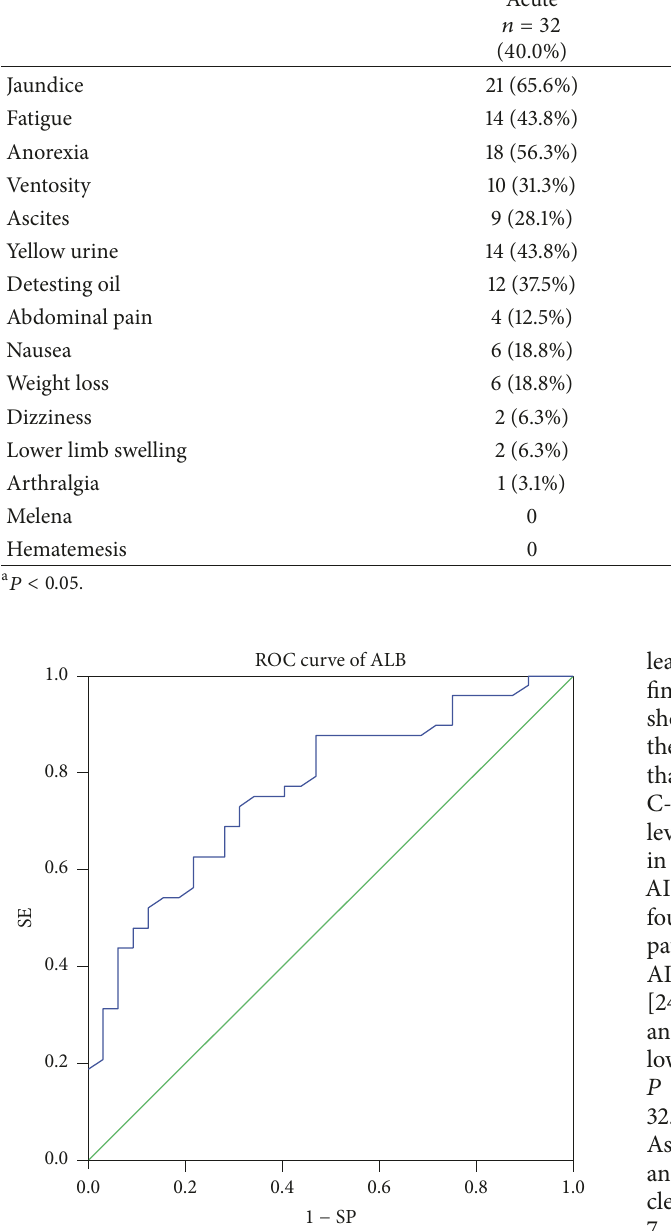
Figure 3: ROC curve of ALB. The area under the receiver operating characteristic (ROC) curve was 0.765 for ALB, 95% confidence interval(CI)was0.662–0.869,andratesforsensitivityandspecificity were 72.9% and 68.7%,